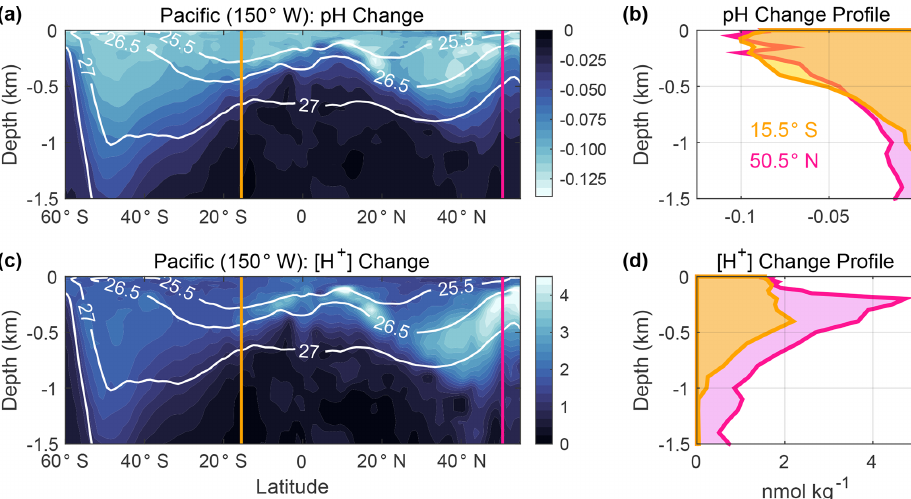
Figure 4. Changes in (a) pH and (c) [H + ] (nmolkg − 1 ) associated with anthropogenic carbon (C anth ) accumulation in the upper 1.5km of the ocean along a meridional transect (150 ◦ W) in the Pacific Ocean from 60 ◦ S to 55 ◦ N. These values were estimated using GLODAPv2.2016b climatology data, which are referenced to the year 2002 (Lauvset et al., 2016) by subtracting the estimated C anth from dissolved inorganic carbon (DIC) and recalculating pH from the modified DIC values along with total alkalinity, silicate, phosphate, temperature, and salinity climatology data. Plotted values are derived from the differences between the pH climatology and recalculated pH values that roughly reflect preindustrial values. This simple approach neglects pH changes caused by processes other than C anth accumulation and is used merely to display the concept of interest. Potential density contours are overlaid in white. Vertical profiles of (b) pH change and (d) [H + ] change at the gold and pink lines are shown in panels (a) and (c) . Calculations were performed using the MATLAB program CO2SYS version 1.1 (van Heuven et al., 2011; Lewis and Wallace, 1998) and applying the equilibrium constants of Lueker et al. (2000) and Dickson (1990) and